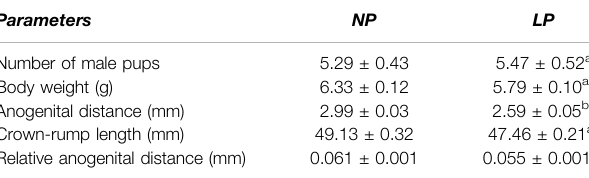
TABLE 2 | Body weight, crown-rump length and absolute and relative anogenital distanceofmalesatbirth(PND1).NP, n =17litters/group.LP, n =19 l/group. Valuesexpressedasmeans±S.E.M.* p < 0.05.Studentt-testewasusedtoasses signi fi cance of differences in parametric data (a) and Mann-whitney was used to asses signi fi cance of differences in non-parametric data